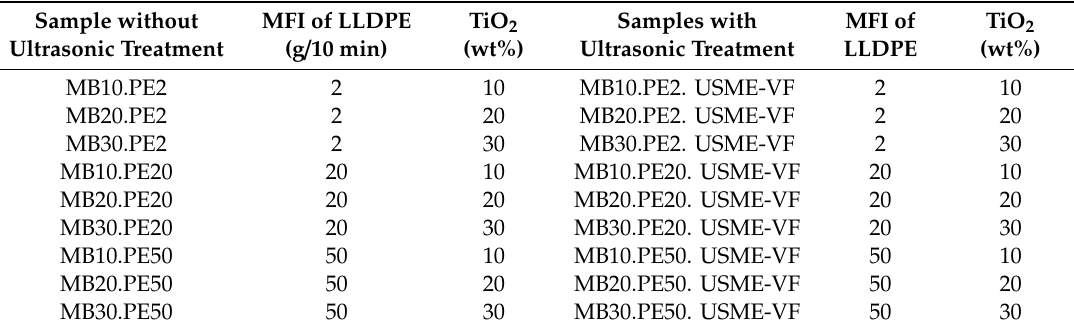
Table 1. Composition and processing conditions of all the masterbatch samples.